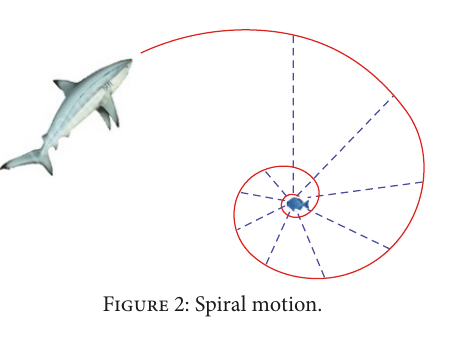
Figure 2: Spiral